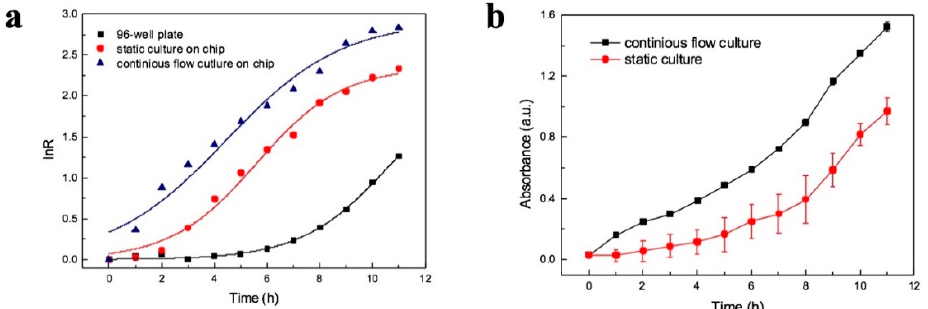
Figure 5. Bacterial growth curve fittings ( a ) 96-well plate, static culture on chip and continuous flow culture on chip ( R = optical density ( OD) / OD 0 ). ( b ) On chip culture in two methods: continuous flow culture and static culture on chip. The error bar is obtained by three of six culture chambers at the same concentration.